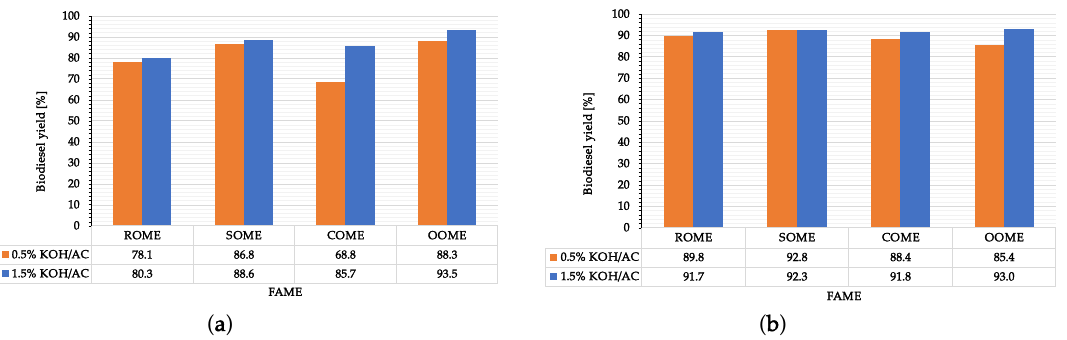
Figure 3. Yield of biodiesel obtained from vegetable oils in the presence of KOH/AC. [Reaction time (a) 1 h and (b) 4 h].